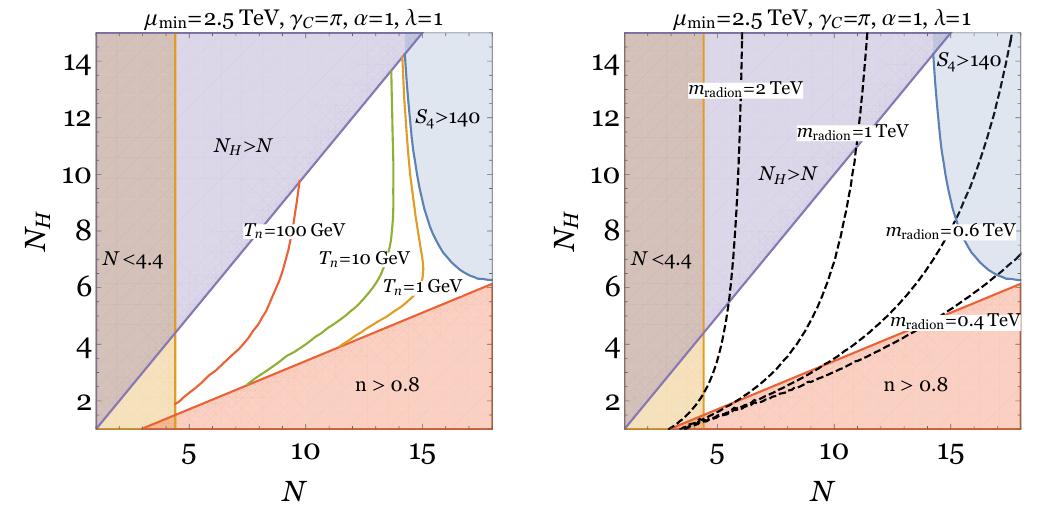
Figure 4 . Exclusion plot in the N H - N plane. We take (cid:22) min = 2 : 5 TeV, (cid:13) c = (cid:25); (cid:11) = 1, and (cid:21) = 1. In the upper-right blue-shaded region, S 4 > 140 from our numerical calculations and the phase transition is not completed. In the bottom-right red-shaded region, n > 0 : 8 and (cid:22) c is of order or smaller than the QCD scale, where the QCD e(cid:11)ect has to be taken into account. In the upper-left blue-shaded region, N H > N and the (cid:12)nite temperature e(cid:11)ect of SU( N H ) has to be taken into account. In the left orange-shaded region, N < 4 : 4 and the quantum gravity e(cid:11)ects have to be taken into account. The white region is allowed by those constraints. The contours in the allowed region in the left panel represent the nucleation temperature, while the dashed contours in the right panel represent the radion